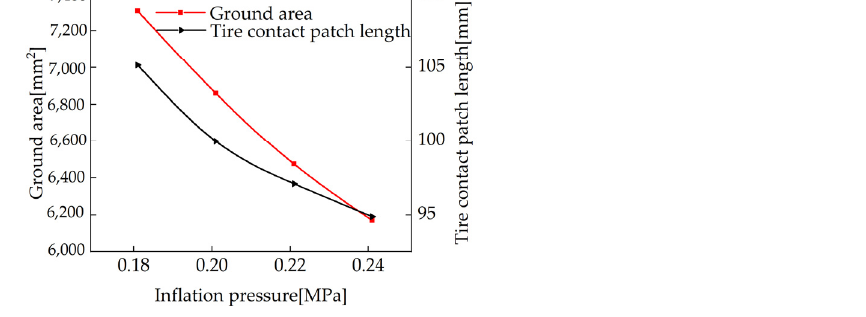
Figure 10. Curves of tire contact area and longitudinal contact length under different inflation pressures.